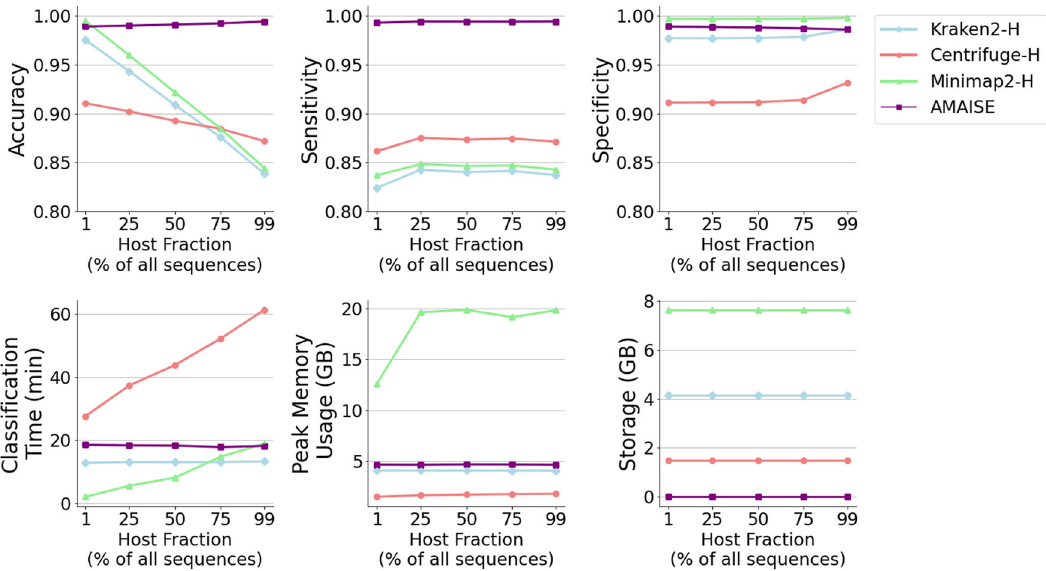
Fig. 2 Performance of AMAISE, Kraken2-H, Centrifuge-H, and Minimap2-H across samples that varied in terms of host percentage. Across samples that varied in terms of host percentage, the performance of AMAISE remained stable. AMAISE consistently achieved higher accuracy while requiring less storage and remaining competitive with respect to classi fi cation time and peak memory usage. Gains in accuracy and speed over Kraken2-H, Centrifuge-H, and Minimap2-H are largest when the fraction of host samples is above 25%.